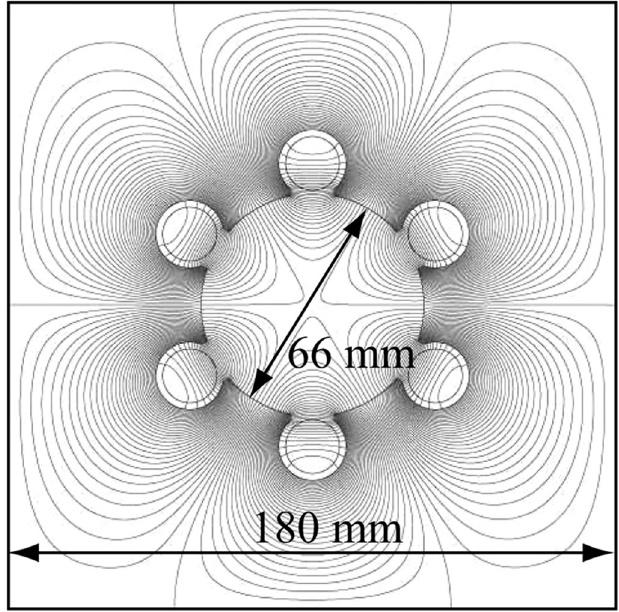
FIG. 12. Cross-sectional view and two-dimensional magnetic field distribution of the PSM. The bore diameter is 66 mm. The coil is a one-turn copper bar with a diameter of 15 mm.